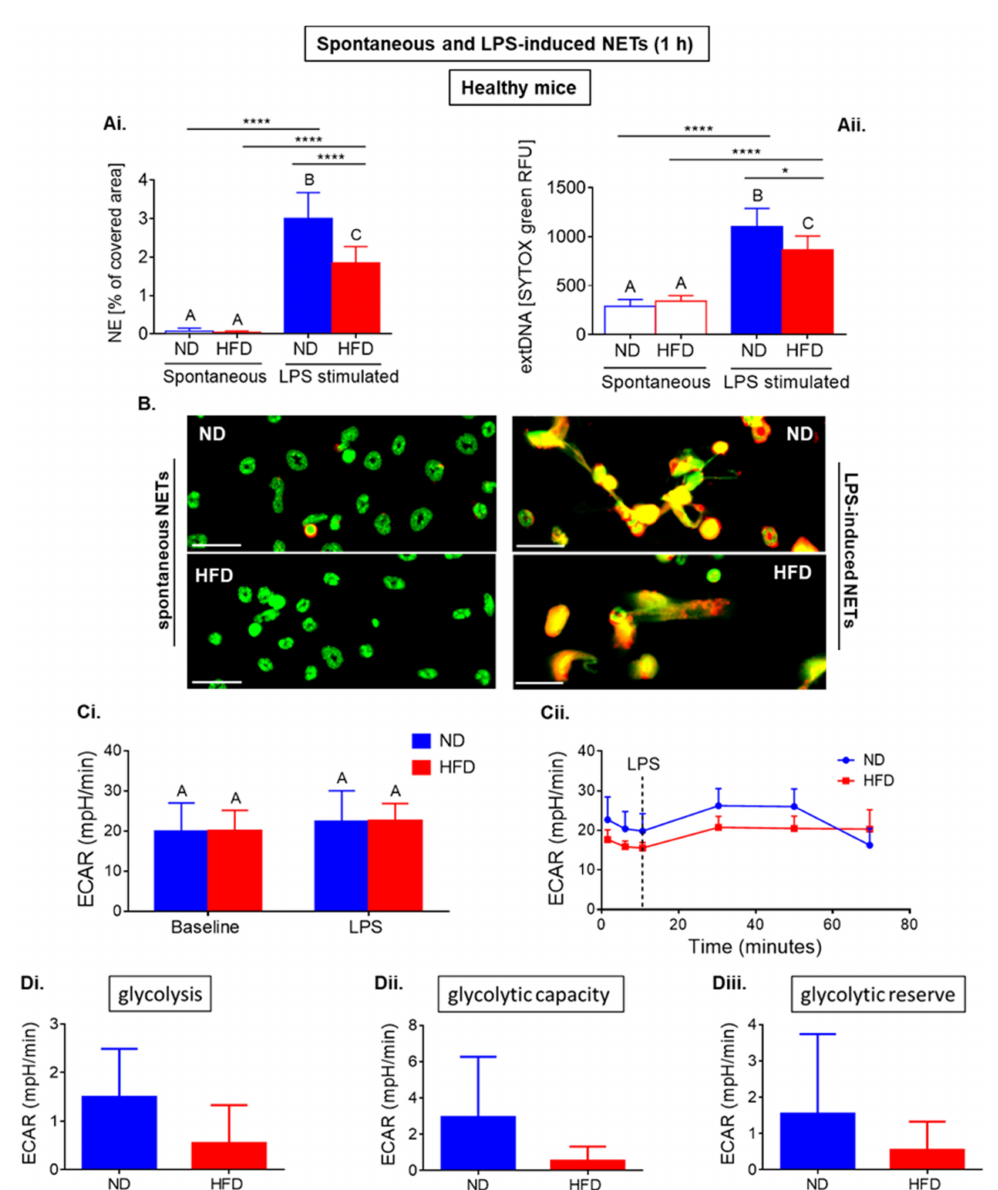
Figure 1. Short-term formation of neutrophil extracellular traps (NETs), and metabolic parameters of neutrophils isolated from healthy mice with obesity induced by high fat diet (HFD) and from their lean controls (ND). Animals were not treated in any way, thus they are described as healthy. NET formation and metabolic parameters were measured within one hour since cell seeding or ex vivo activation with lipopolysaccharide (LPS). NETs were quantified upon staining of neutrophil elastase (NE, ImageJ software) ( Ai ), and ( Aii ) extracellular DNA (extDNA) with SYTOX green; fluorescent signal was quantified using a microplate reader (relative fluorescence units, RFU); ( B ) representative images of NETs are presented for spontaneous NETs of ND and HFD mice and for NETs induced with lipopolysaccharide (LPS). NETs were detected by immunocytochemical counterstaining of neutrophil elastase (NE, red) along with extracellular DNA (extDNA, green). Scale bars indicate: 25 µ m. Metabolic parameters were measured with Seahorse analyzer ( C , D ). Data quantification of Extracellular Acidification Rate (ECAR) ( Ci ) and a representative Seahorse readout ( Cii ) are presented. ( D ) Glycolysis Stress Test was used to establish glycolysis rate ( Di ), glycolysis capacity ( Dii ), and glycolytic reserve ( Diii ). Asterisks indicate significant differences between groups according to unpaired two-tailed Student’s t -test (* p ≤ 0.05, **** p ≤ 0.0001). Results of one-way ANOVA (post hoc Bonferroni): any two means that do not share same letter are significantly different. Data are shown as mean ± s.d.; n ≥ 3 per